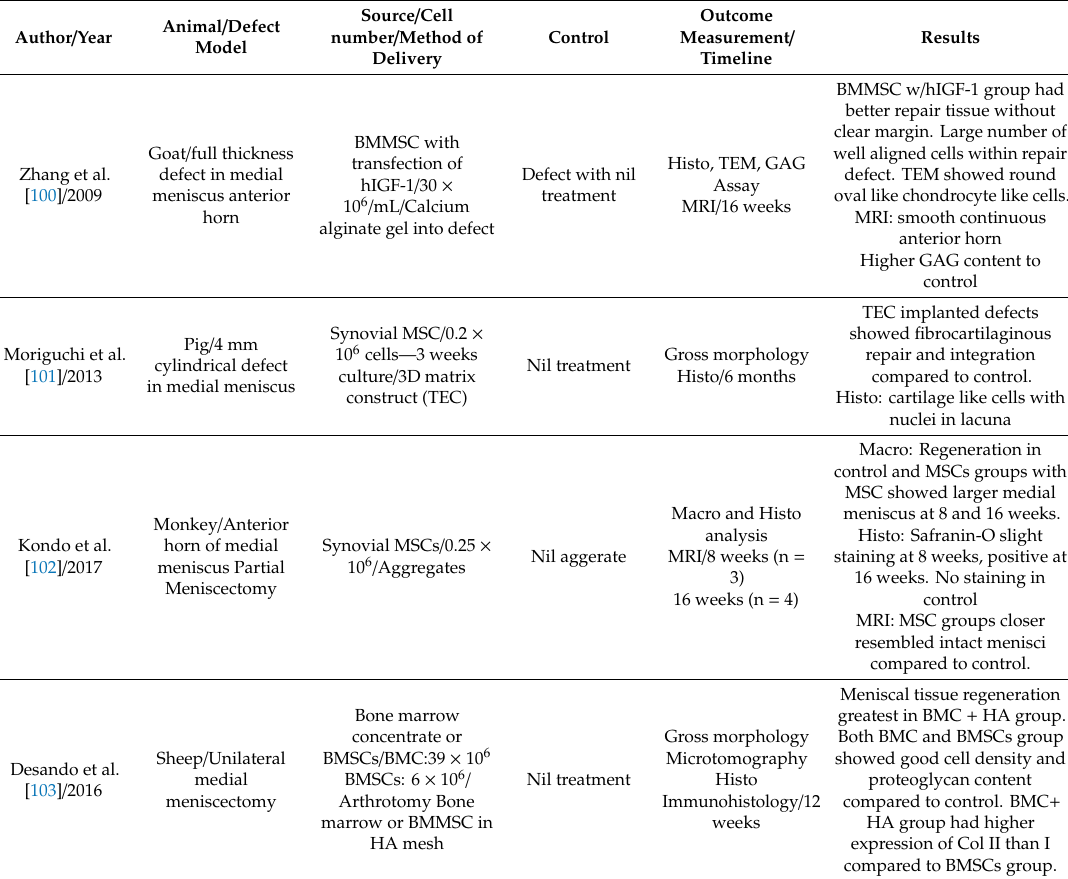
Table 3. Summary of pre-clinical studies using tissue